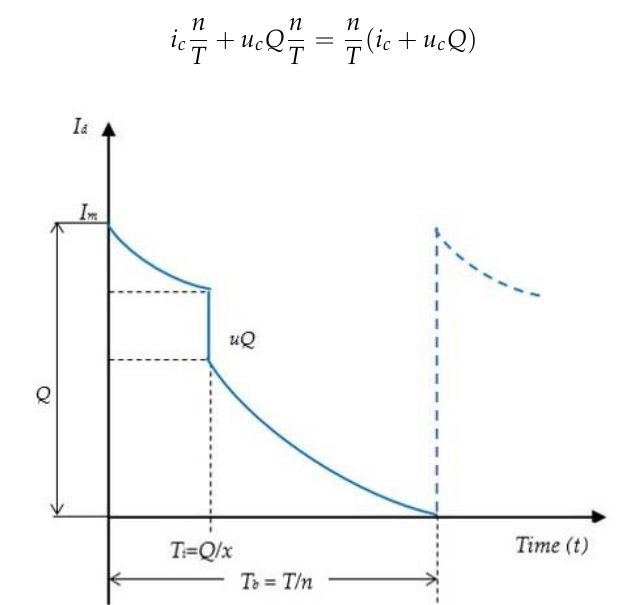
Figure 5. Retailer’s inventory model with imperfect quality per delivery cycle .